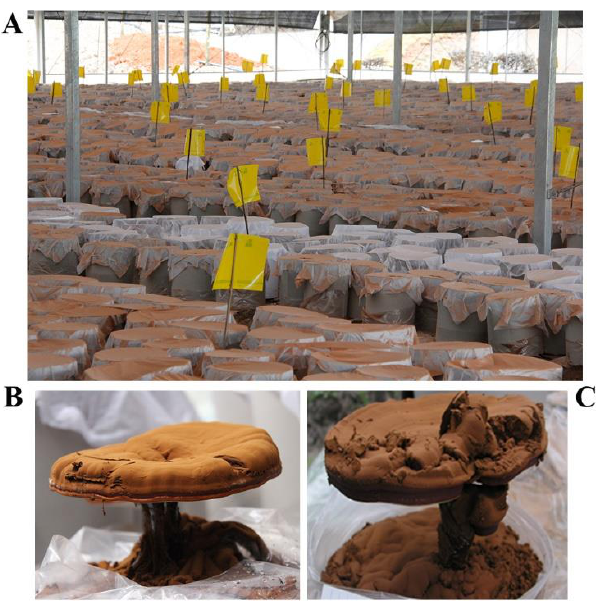
Figure 6. Some spawn of G. lucidum were contaminated by soil microorganisms.